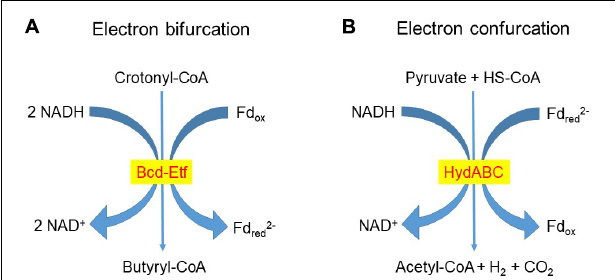
FIGURE 3 | Examples of (A) Electron bifurcation and (B) Electron confurcation redox reactions. Electron bifurcation in the reduction of Fd ox by NADH coupled to the reduction of crotonyl-CoA to butyryl-CoA catalyzed by Bcd-Etf was proposed by Hackmann and Firkins (2015) to operate in rumen butyrivibrios (genera Butyrivibrio and Pseudobutyrivibrio ). In the rumen bacterium R. albus the electron-bifurcating hydrogenase HydABC catalyzes the formation of dihydrogen (H 2 ) from NADH and reduced ferredoxin (Fd red2 - ) (Zheng et al., 2014; Buckel and Thauer,